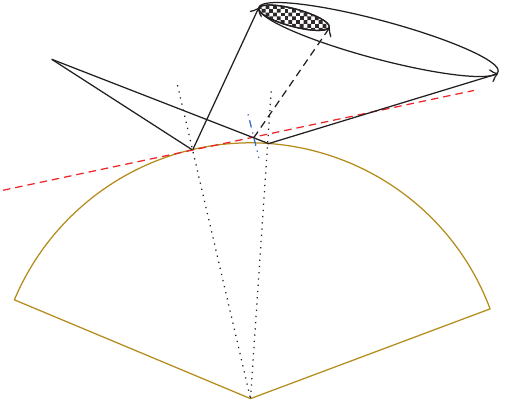
Figure 20: Divergence effect.